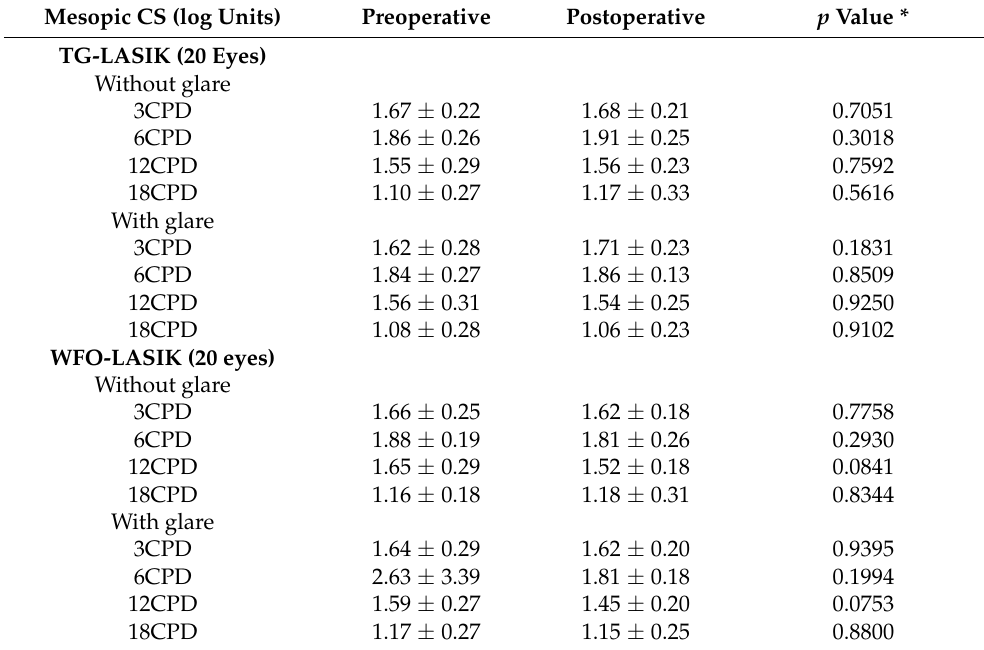
Table 4. Preoperative and postoperative contrast sensitivity between TG-LASIK groups after 3 months.